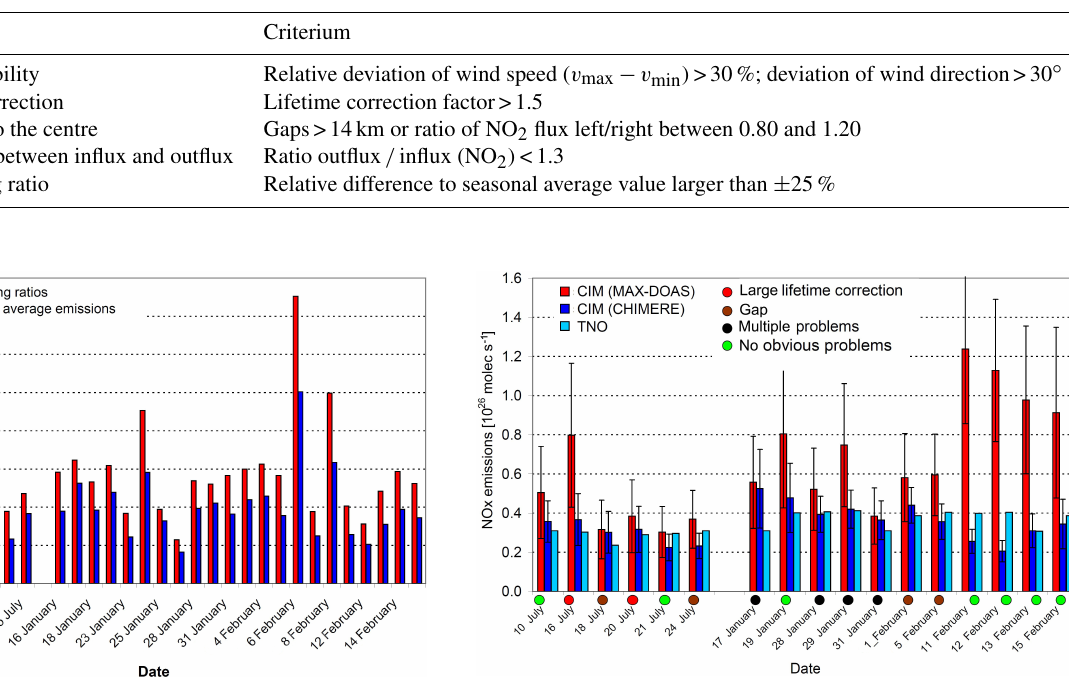
Table 2. Criteria used for the identification of different problems.